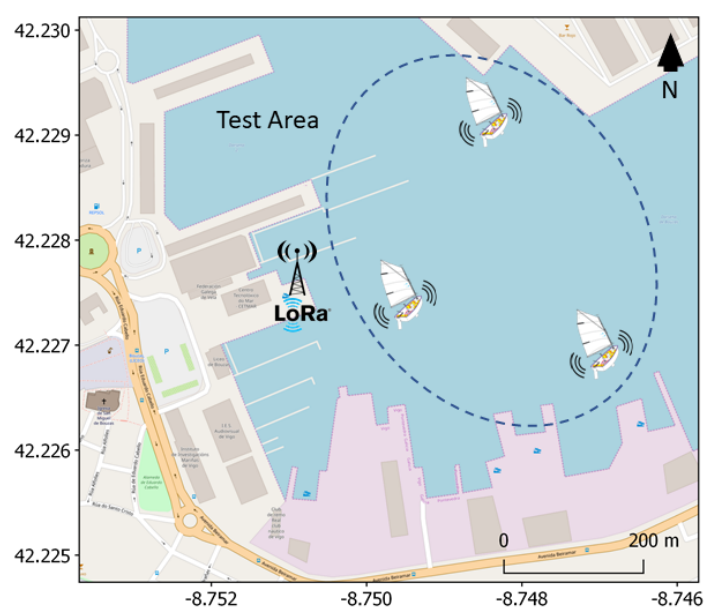
Figure 6. Test scenario in the port of Vigo (Spain).